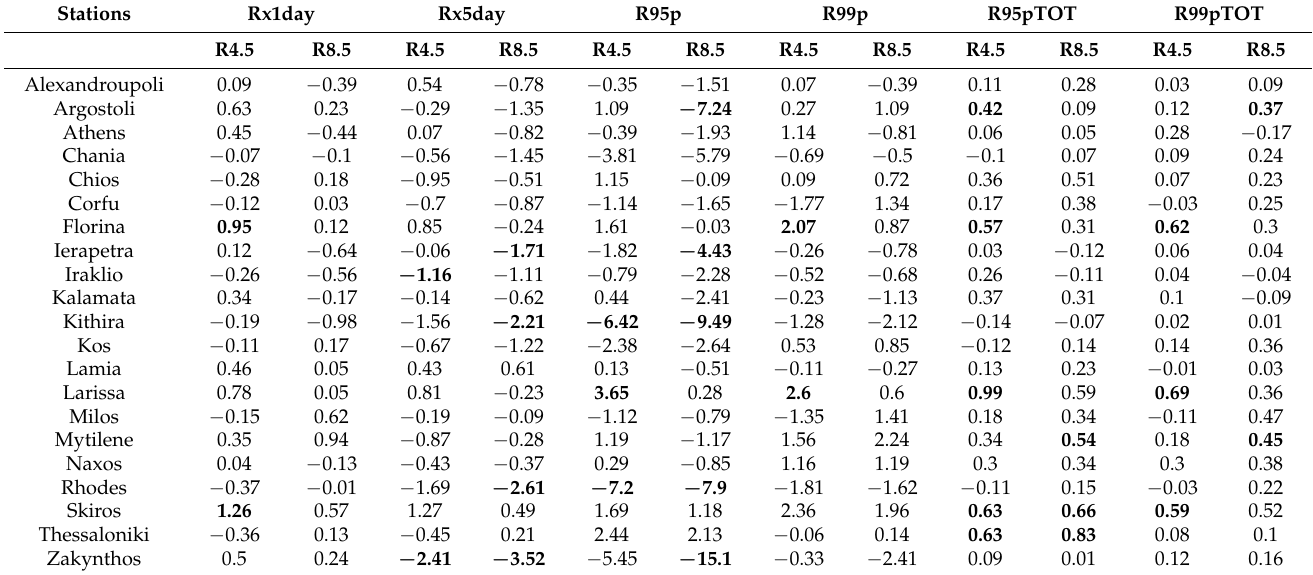
Table 4. Same as Table 3 for the remaining precipitation